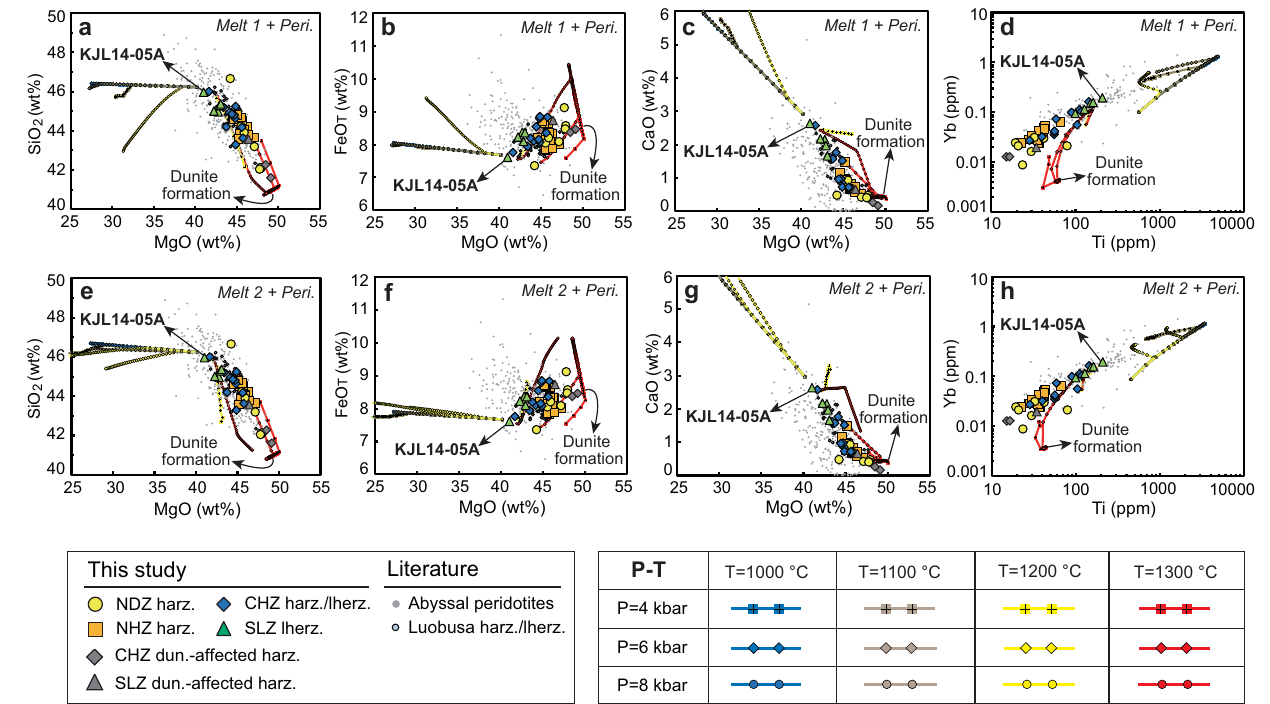
“ Melt 2+Peridotite ” in ( e – h ). The modeling conditions (P and T) and the compo- sitions of Melt 1, Melt 2, and Peridotite (lherzolite KJL14-05A) have been shown in Supplementary Dataset 10. Along with the addition of melts, the reactions at 1300°Cwillcontinueuntiltheformationofpuredunite.Grayandlight-bluecircles represent abyssal peridotites 13 – 15 and the published Luobusa peridotites 20,32,35,38 ,